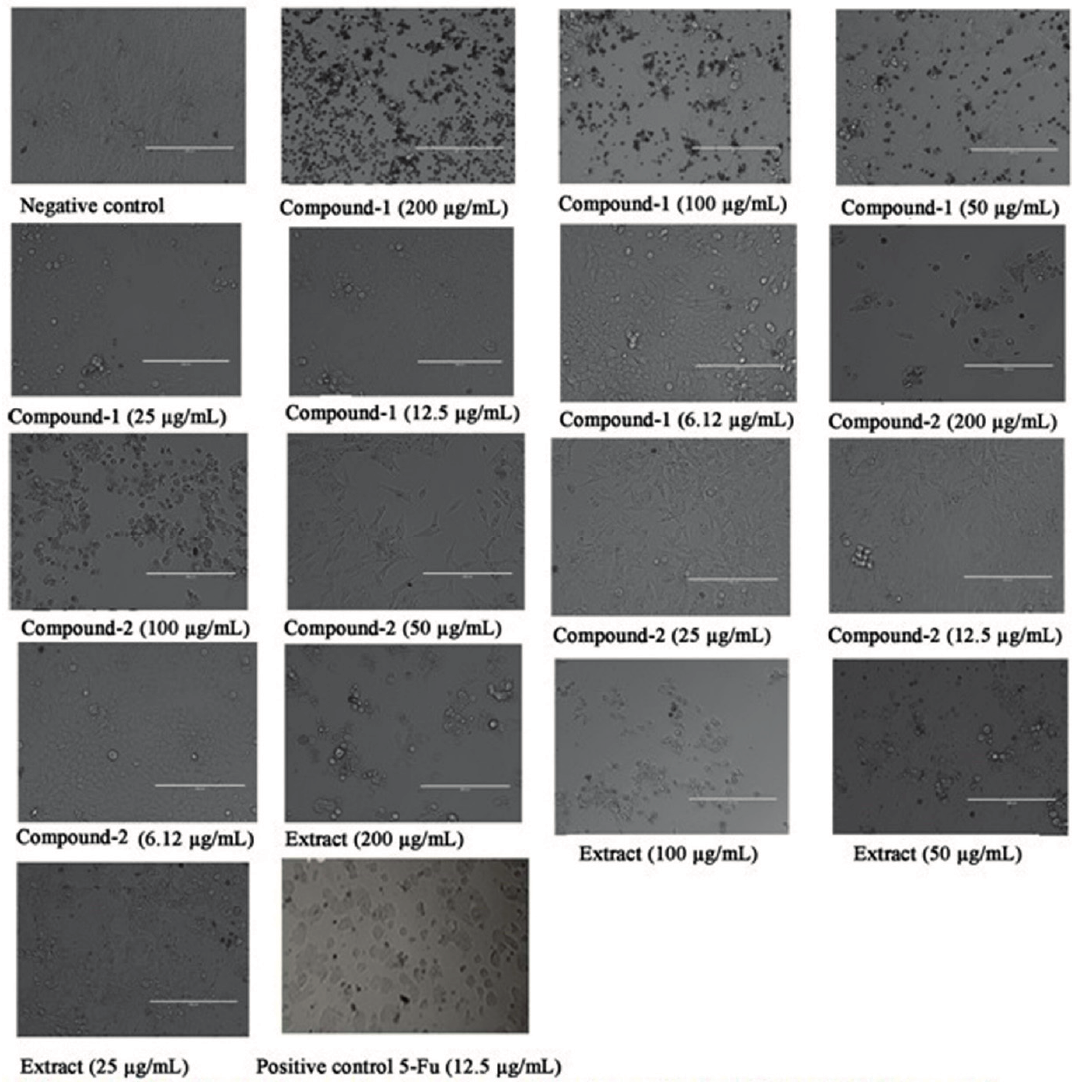
Figure 10. Dose dependent anti-proliferative effect of (2 S )-7-Hydroxy-5-methoxy-6,8- dimethyl flavanone (compound- 1 ), ( S )-5,7-dihydroxy-6,8-dimethyl flavanone (compound- 2 ) and S. campanulatum ethanolic extract on HCT 116 cell lines was assessed by